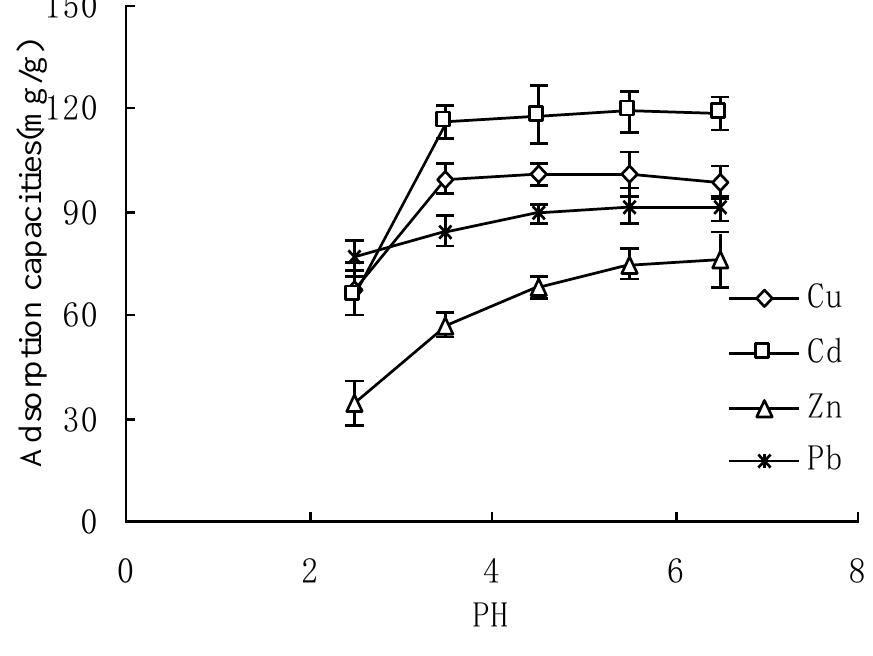
Figure 5. Influence of initial solution pH on adsorption capacities of CCM for heavy metal ions (initial metal concentration = 100 ppm; agitation speed = 180 rpm; equilibrium time = 2 h; temperature = 25